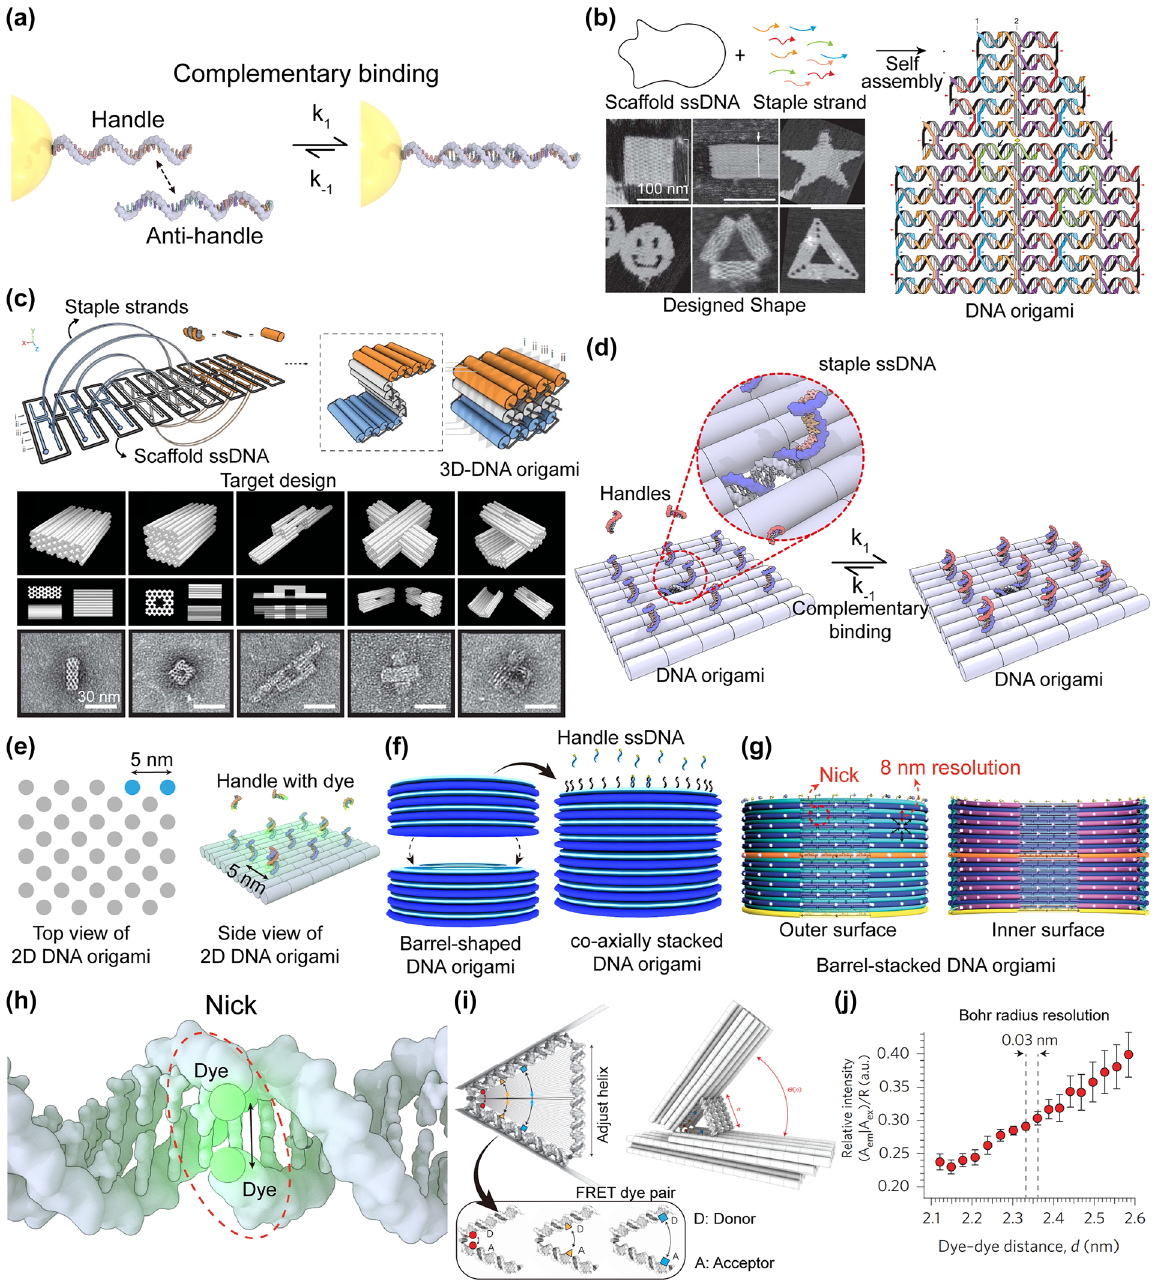
Figure 2: DNA origami for MQE’s pegboard, (a) the complementary binding of ssDNA decorated on the surface of AuNP with anti-handle. (b) Self-assembly of DNA origami with a scaffold ssDNA with various staple strands. The AFM images of various shapes including square, rectangle, star, disk with three holes, triangle with rectangular domain, and sharp triangle with trapezoidal domain [63]. (c) Schematic design of construction 3D DNA origami [64]. (d) The complementary binding mechanism between handles and anti-handles, hanging from the scaffold of the DNA origami (the gray strand). (e) The schematic representation for the positions of ssDNA anti-handles on DNA origami. The approximate distance between the adjacent ssDNA anti-handles is around ∼ 5 nm, which implies that the dye within handles can blink on DNA origami with ∼ 5 nm resolution. (f) Schematic design of two barrels coaxially stacked 3D DNA origami. With help of ssDNA, the fluorophore dyes can be positioned on to the specific sites. (g) Inner and outer surface of 3D barrel DNA origami. The fluorescent dye can be tagged on a nick with 8 nm resolution [77]. (h) Two dyes located on adjacent ‘nick’ within 1 nm. (i) DNA origami based high-resolution device for positioning two dyes by adjusting the distance of helix to induce the Förster resonance energy transfer (FRET) [35]. (j) The graph indicates the controllability of dye-to-dye distance within 0.03 nm resolution, which is comparable to Bohr radius. Part (b) adapted with permission from Ref. [63]. Part (c) adapted with permission from Ref. [64]. Part (g) adapted with permission from Ref. [77]. Parts (i) and (j) adapted with permission from Ref.